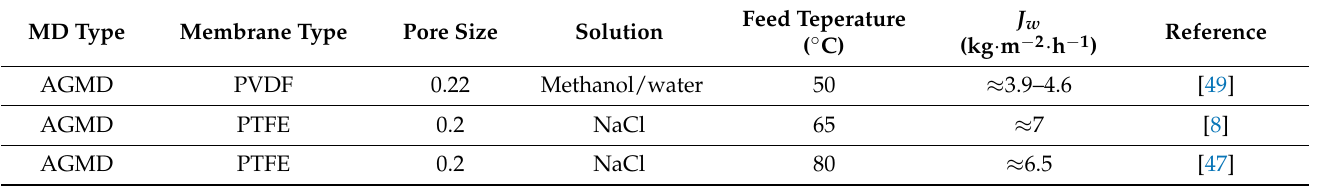
Table 1. Summary of permeate flux for different MD configurations from the literature.